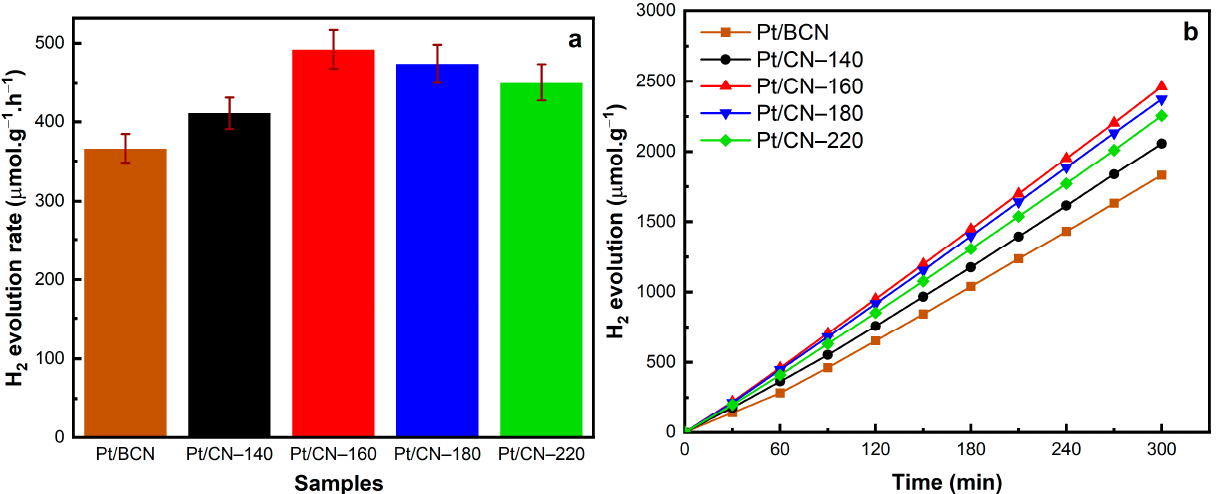
Figure 8. The H 2 evolution rates ( a ) and photocatalytic H 2 evolution results over time ( b ) of the Pt/BCN and Pt/CN photocatalysts.